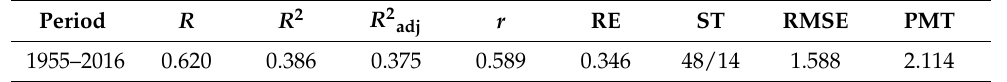
Table 2. Statistics of the leave-one-out calibration results for the common period of 1955–2016.